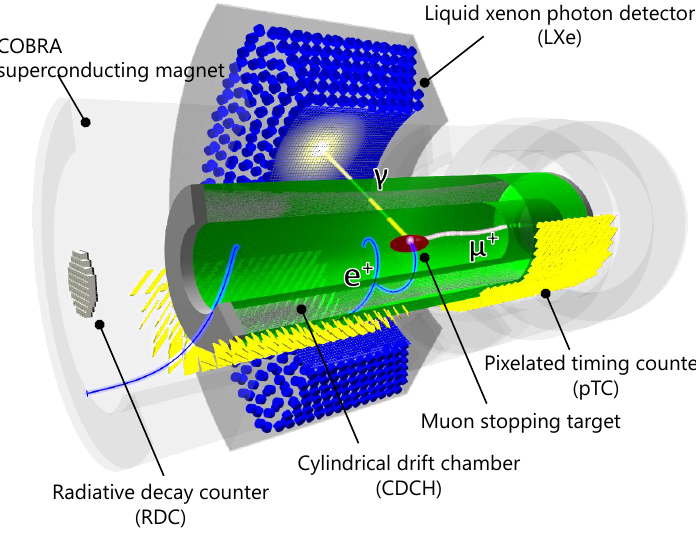
Figure 1. Drawing of the detectors constituting the MEG II